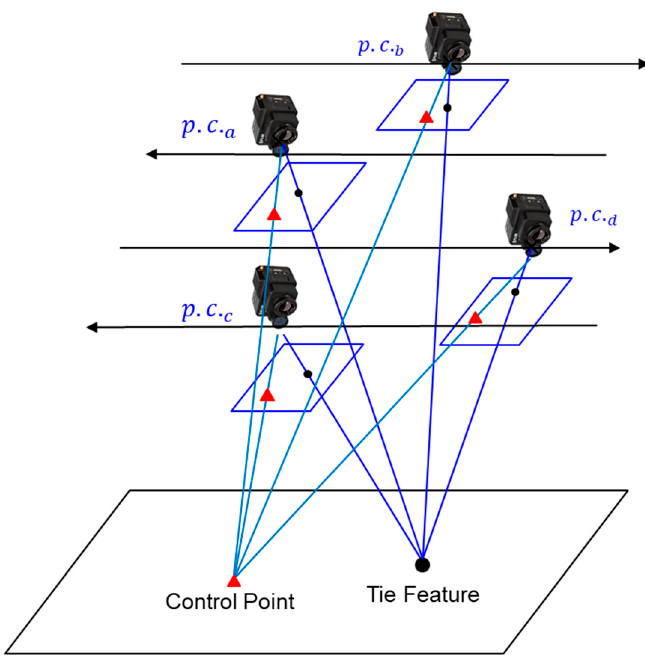
Figure 2. Conceptual basis of bundle block adjustment.